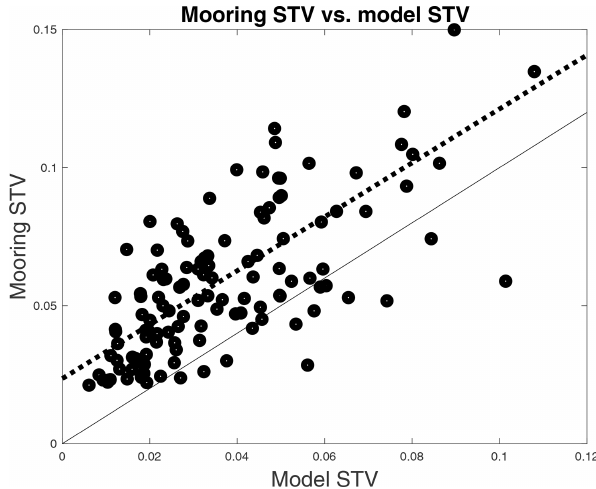
Figure 10. Model STV vs. mooring STV. Each symbol represents the median STV for one mooring. A couple of outlier points have been omitted for clarity. The dashed line is a least-squares fit to the data. It has a slope of about 1 and an intercept of about 0.02. The light black line has a slope of 1. This plot indicates that the mooring STV is generally larger than the model